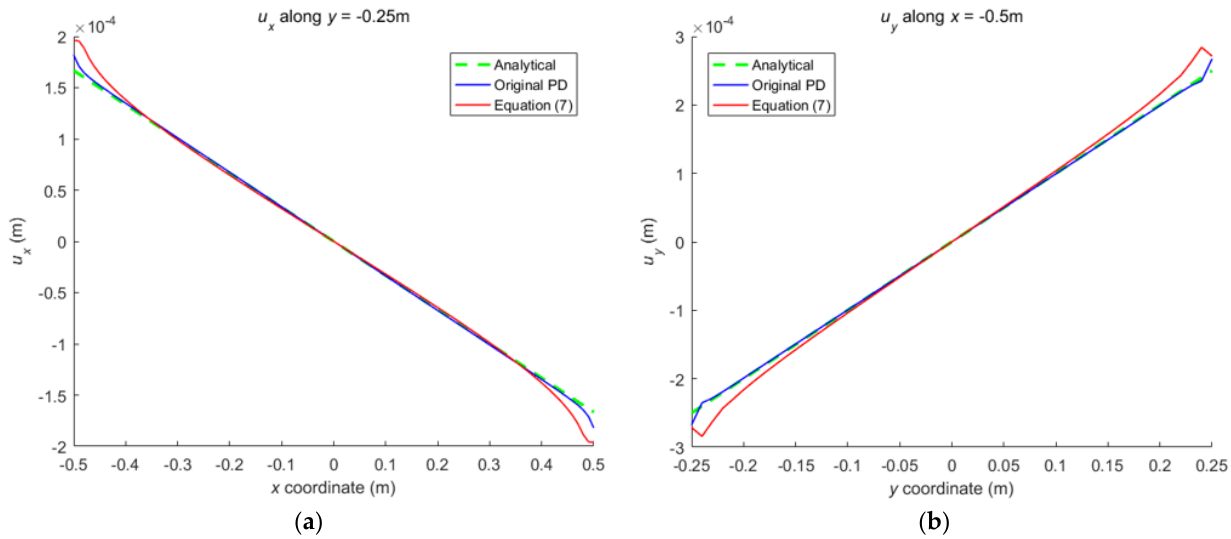
Figure 8. The displacement along the bottom side and left side of the rectangular plate subjected to tension: ( a ) u x along y = − 0.25 m; ( b ) u y along x = − 0.5